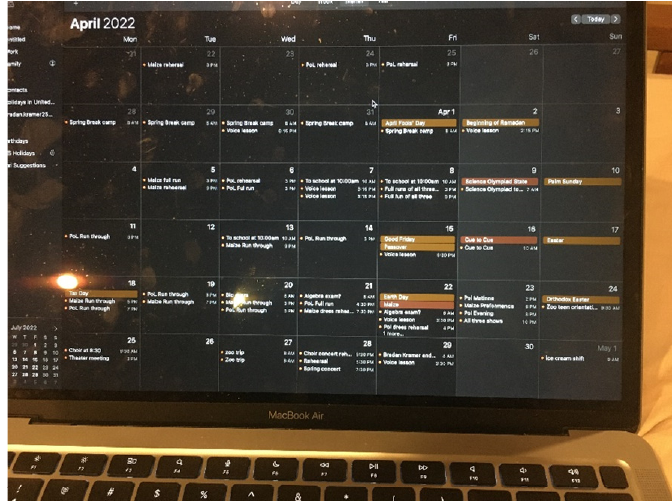
Figure 10. One participant’s schedule, not including the school day.